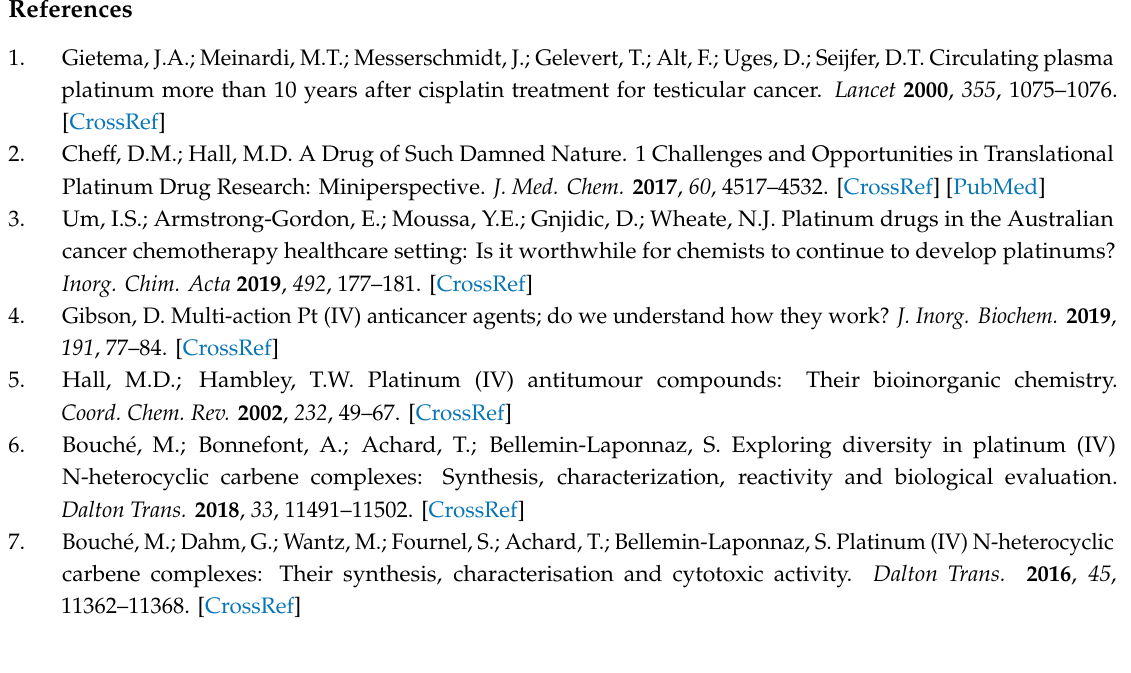
Supplementary Materials: The following are available online. 195 Pt NMR spectra and characterization for all